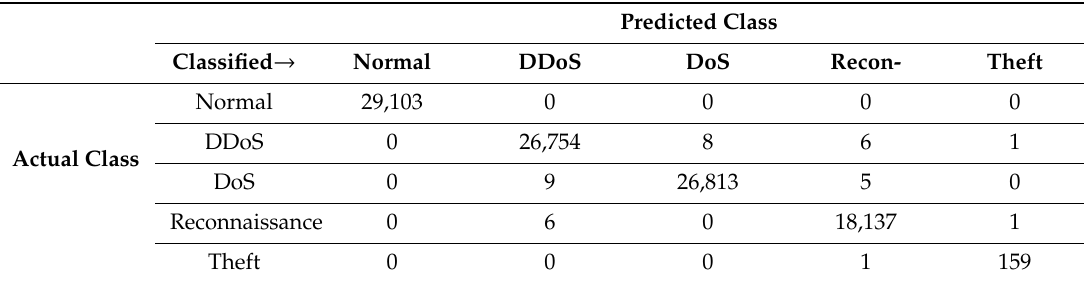
Table 8. Contingency Matrix for Category.